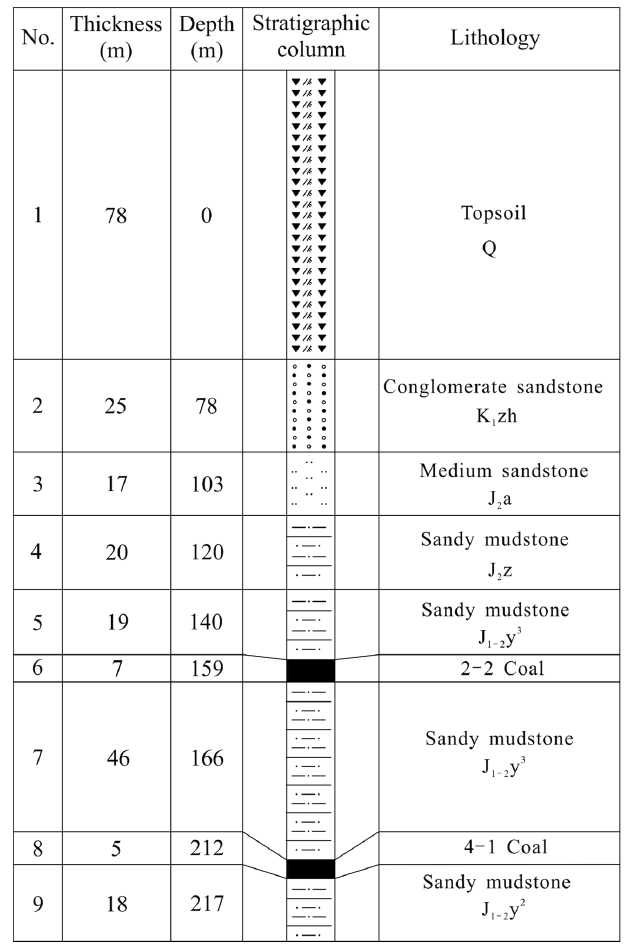
Energies 2019 , 07 , x FOR PEER REVIEW Figure 2. Location of Yangjiacun Coal Mine in Dongsheng Coal Field of Ordos City, inner Mongolia. The Yangjiacun Coal Mine is located in the middle of the Dongsheng Coal Field (as shown in Figure 2). The coal reserve is 976.82 million tons, and the available reserve based on mine design is 441.82 million tons. The expected mining capacity is 5.0 million tons per year, and the service life is 63.3 years. The main minable coal seams of the Yangjiacun Coal Mine are the 2 ‐ 2 and 4 ‐ 1 coal seams. The average thickness of the 2 ‐ 2 coal seam is 7.0 m, and the average depth is 165 m. The average thickness of the 4 ‐ 1 coal seam is 5.0 m, and the average depth is 218 m. The stratigraphic section is shown in Figure 3. Yangjiacun Coal Mine was built in November 2008 and started mining in May 2011. All coal mining adopted the longwall mining method and the forced roof caving method.